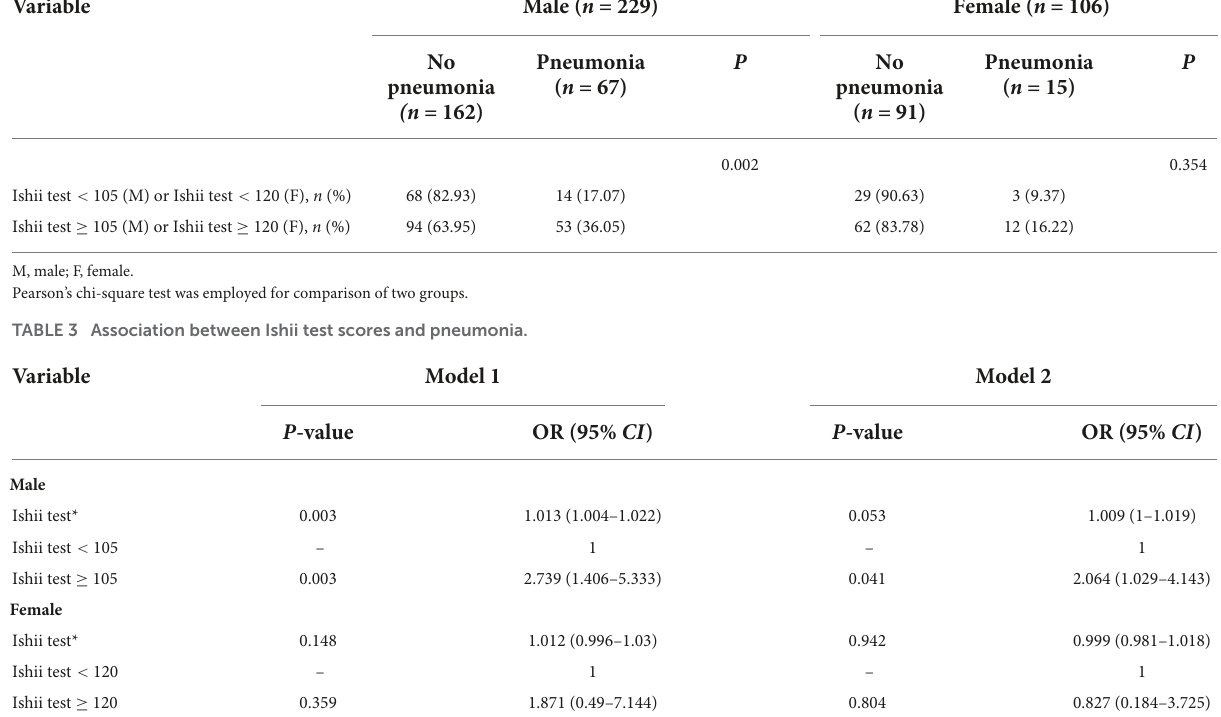
TABLE 2 Analysis of Ishii test scores and incidence of pneumonia.